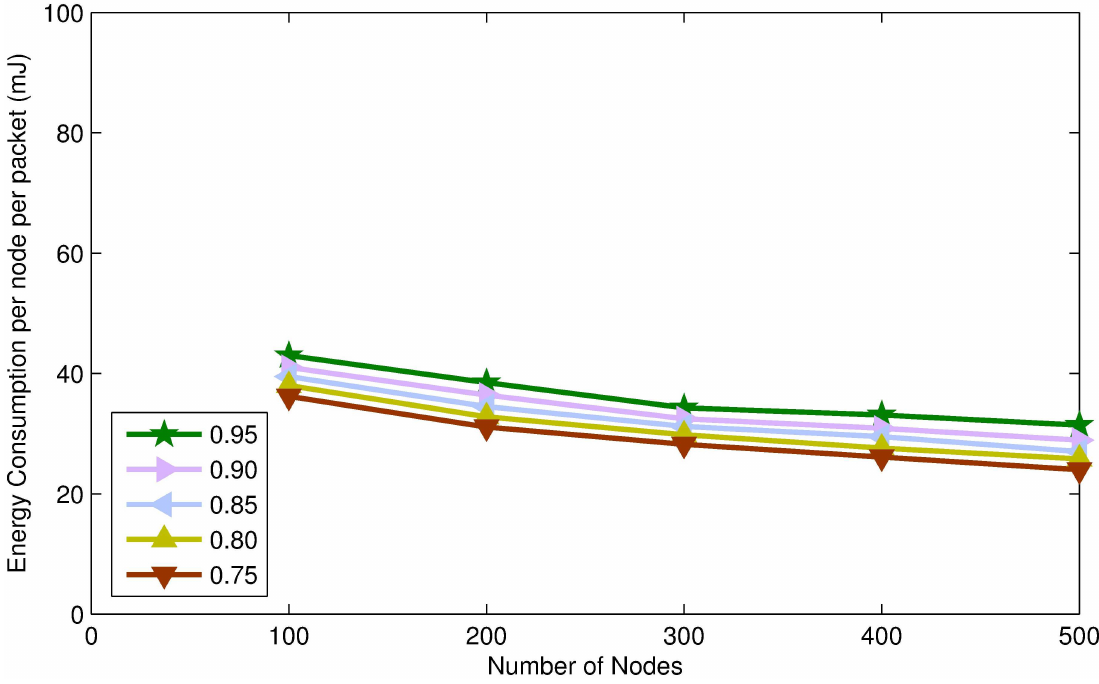
Fig 5. Energy consumption per node per packet vs. node